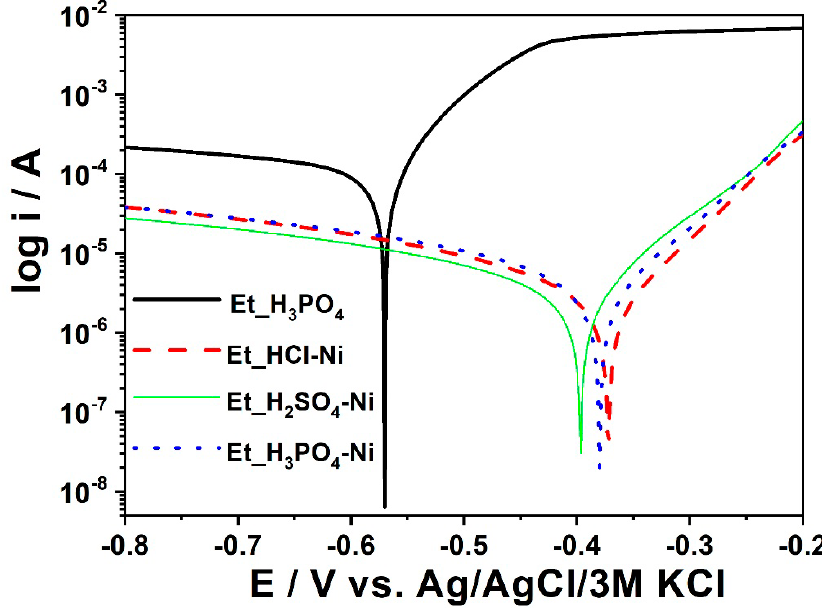
Figure 19. Polarization curves obtained for the Et_H 3 PO 4 , Et_HCl ‐ Ni, Et_H 2 SO 4 ‐ Ni, and Et_H 3 PO 4 ‐ Ni